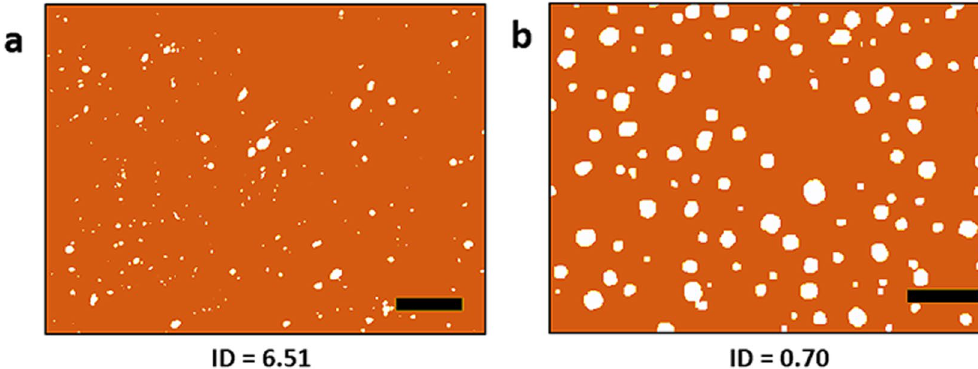
Figure 4. Binarized images and Index of Dispersion processed by ImageJ for spatial distribution analysis. ( a ) A typical optical microscope image from a longitudinal cross-section of the initial composite preform processed by ImageJ software (scale bar is 100 μ m). ( b ) A typical SEM image of the longitudinal cross-section of the PES- 5Sn nanocomposite fiber processed by ImageJ software (scale bar is 300